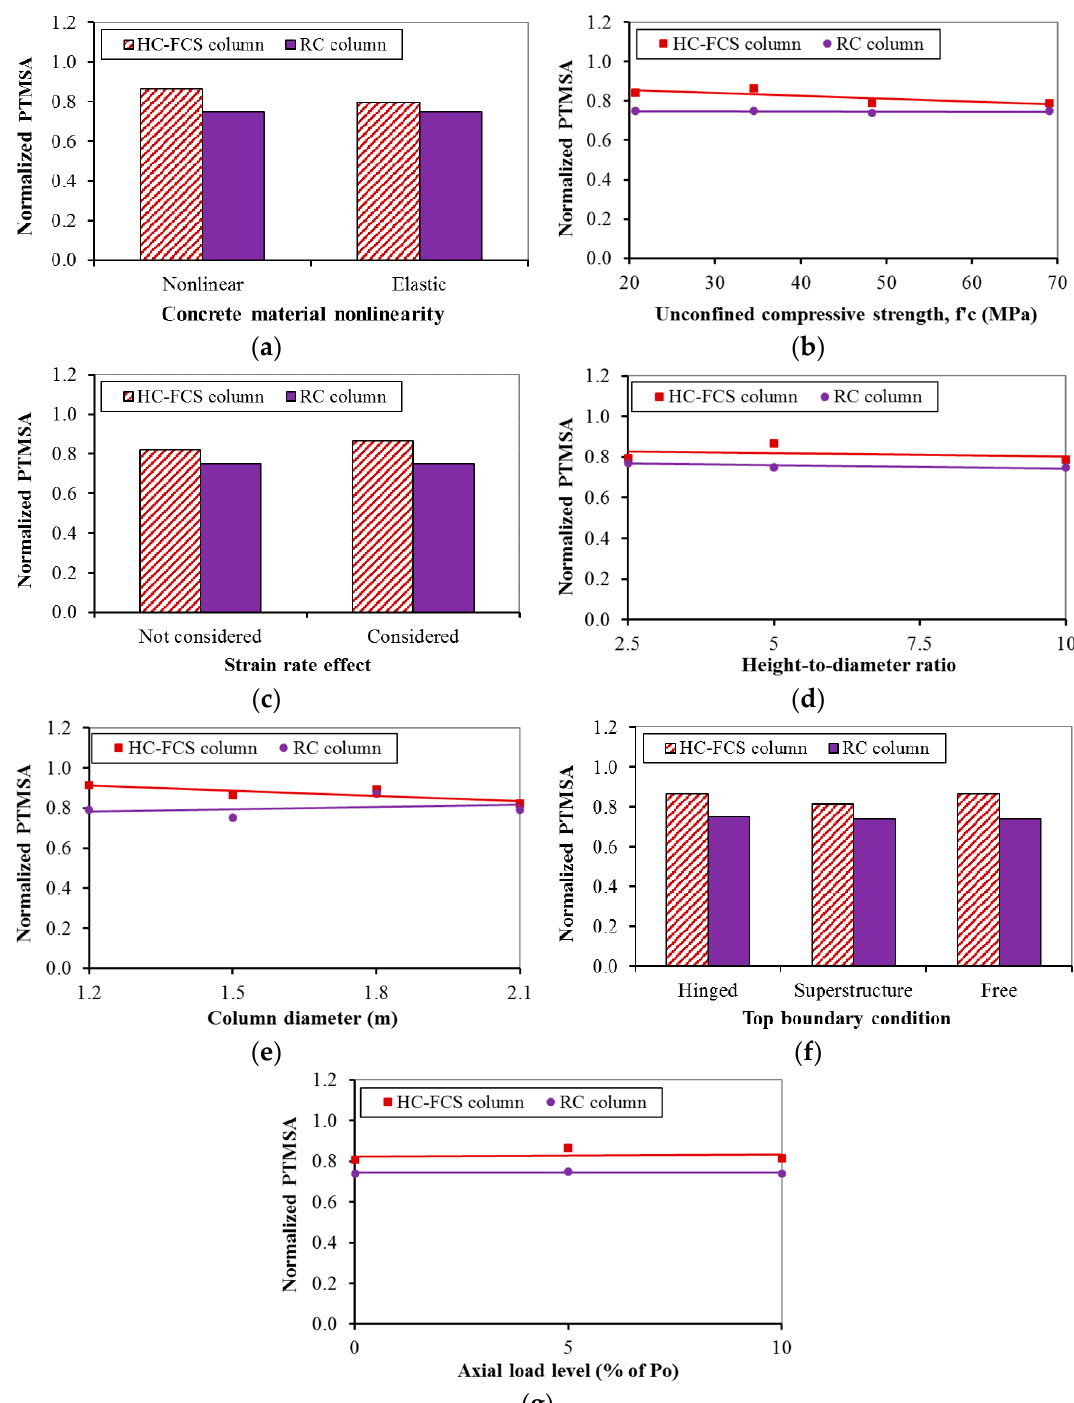
Figure 7. Effects of: ( a ) concrete material model; ( b ) concrete strength ( (cid:1858) (cid:3030)(cid:4593) ); ( c ) strain rate; ( d ) height- to-diameter ratio; ( e ) column diameter; ( f ) top boundary condition; and ( g ) axial load level on the PTMSA of the HC-FCS and RC